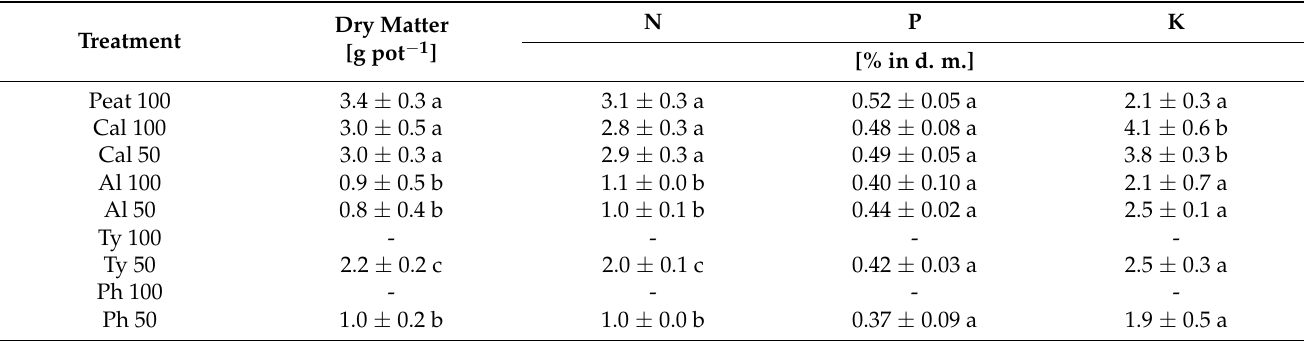
Table 5. Dry matter and N, P, K (% in d. m.) of the cabbage biomass at the end of the experiment in stage 1. N = 4, variance analysis: Kruskal–Wallis, post hoc test: pairwise t test, p < 0.05. d.m.: dry matter. Explanation of treatment names see Table 1. Different letters indicate significant differences among treatments.